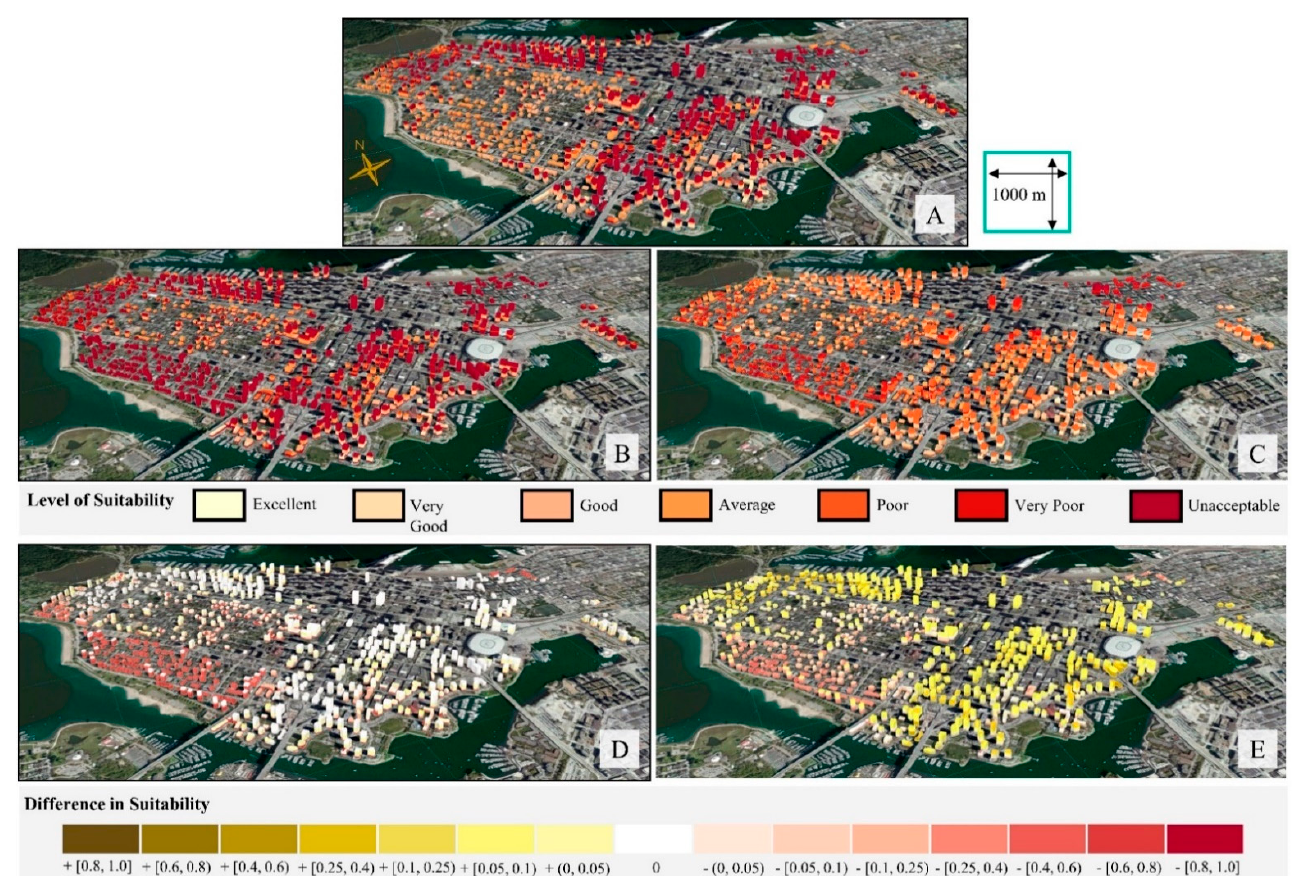
Figure 8. The 3D suitability maps for initial Scenario 1 ( A ) and the sensitivity analysis results for Scenario 1 with ( B ) more mandatory attributes and ( C ) no mandatory attributes and the calculated corresponding 3D difference maps ( D , E ), respectively. Change in overall suitability compared with the original Scenario 1 is expressed as the increase or decrease in suitability resulting from parameter variation.